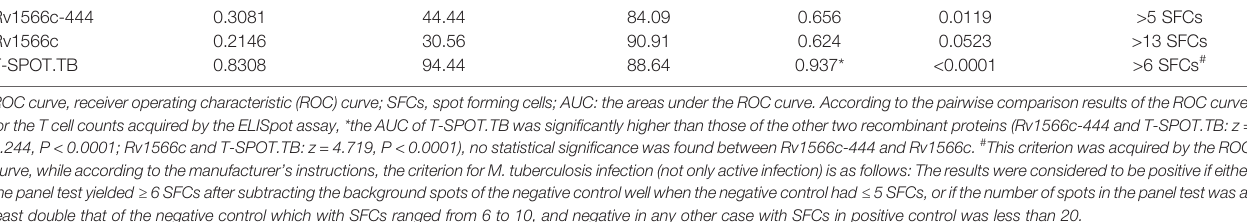
TABLE 2 | Evaluation results from the ROC curve of the recombinant proteins for active Mycobacterium tuberculosis infection diagnosis through ELISpot assay. Antigens Youden index Sensitivity (%) Speci fi city(%) P -value